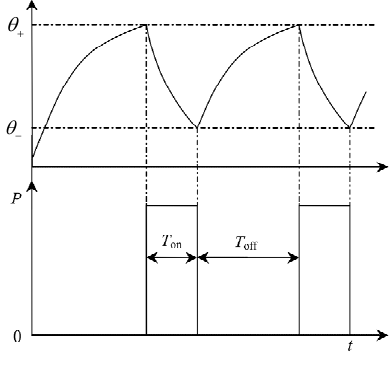
Figure 1. Periodical properties of the temperature inside the house and the power of air conditioners